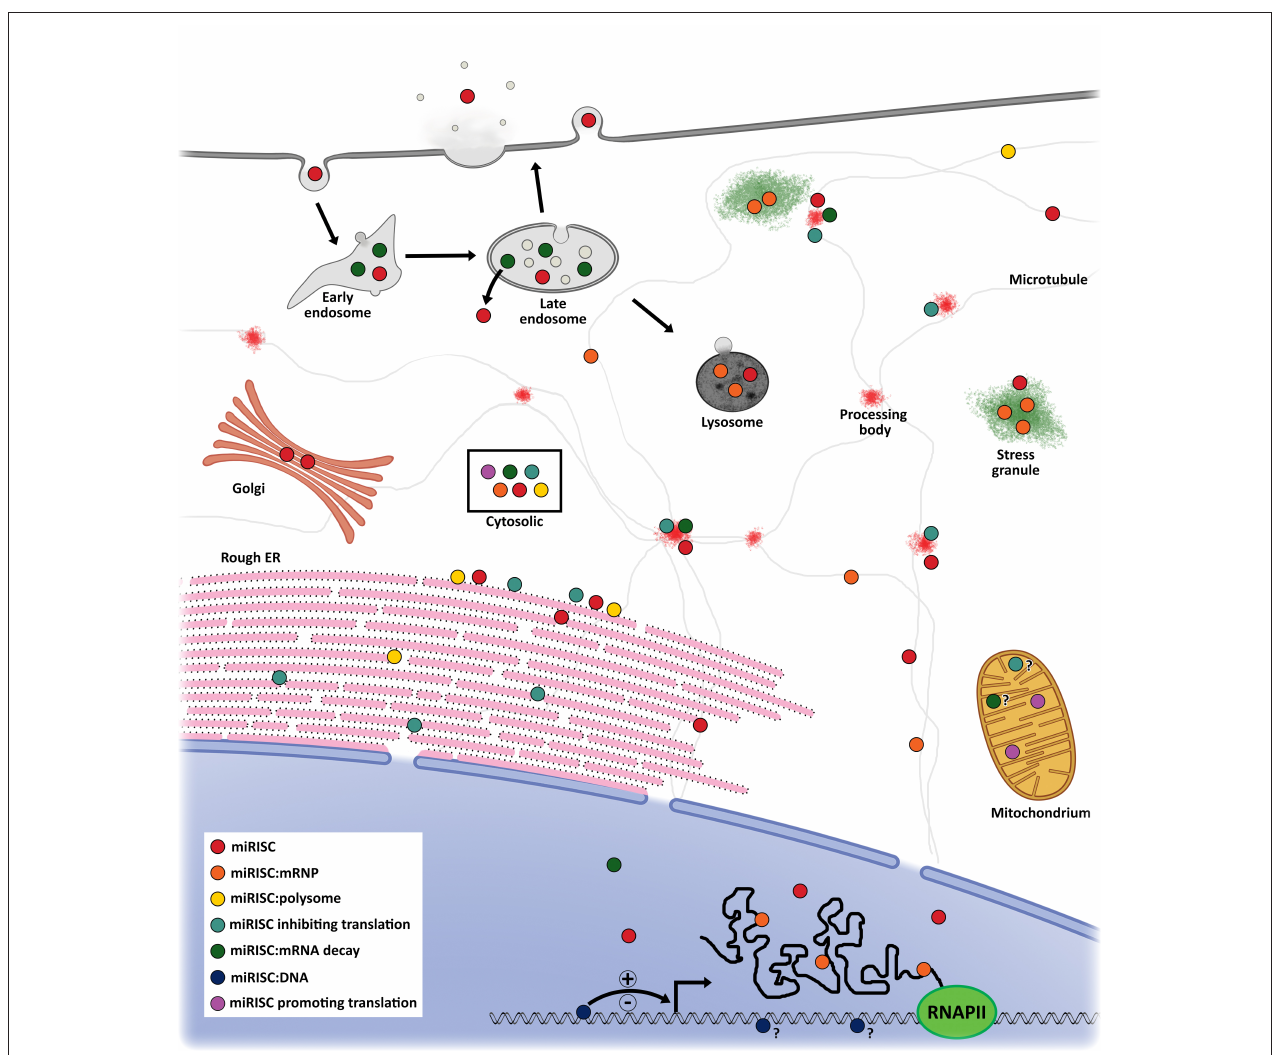
FIGURE 2 | Proposed model of miRNA localization and function. miRISC has been detected in several subcellular locations. In the nucleus, miRISC is enriched at sites of active transcription where it can interact with DNA to promote active or inactive chromatin states. It can also interact with nascent mRNA to promote more efficient splicing or alternate splicing profiles. miRISC can interact with nuclear messenger ribonucleoprotein (mRNP) to promote its degradation or remain in A miRISC:mRNP complex as it is shuttled out of the nucleus. Cytoplasmic miRISC can diffuse throughout the cytosol or undergo shuttling, most likely via microtubules. Within the cytosol, miRISC can associate with polysomes, inhibit translation initiation, mediate mRNA decay, or promote translational activation. On the rough endoplasmic reticulum, miRISC can interact with translating mRNA to inhibit translation. Furthermore, unbound miRISC can also accumulate on the rER to interact with newly rER-bound mRNA. Rough ER miRISC:mRNP complexes that are translationally inhibited can shuttle to the early/late endosomes to complete mRNA deadenylation and decay. miRISC can then be recycled into the cytosol or shuttled to the lysosome for degradation. miRISC may also localize to transient, membrane-free processing bodies where it can mediate target mRNA translational inhibition and storage or decay. Under certain cellular conditions, miRISC:mRNPs may be shuttled to stress granules for storage and/or degradation. miRISC can also localize to the mitochondria to promote translational activation or mRNA translational inhibition and decay. Localization of miRISC within the Golgi is likely from vesicles secreted from the early endosome. Moreover, endocytosed miRISC may be shuttled to the Golgi or recycled into the cytosol. Lastly, vesicular or vesicle-free miRISC can be exocytosed from at least the late endosome into the extracellular milieu to mediate cell-cell